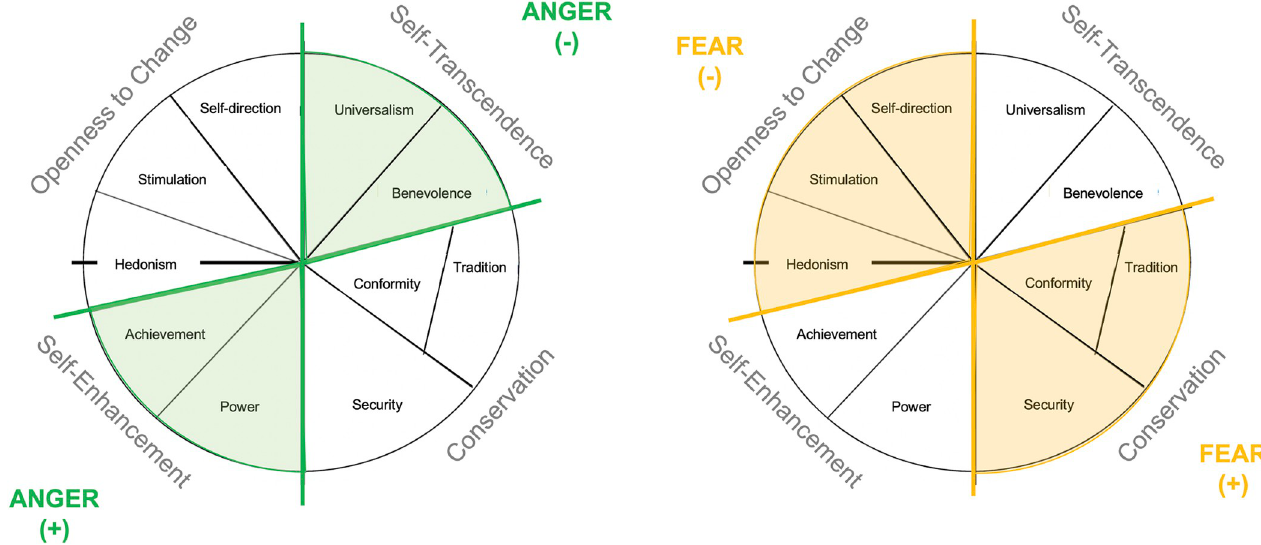
Fig 5. Main results on relations of ANGER and FEAR with the individual value types according to